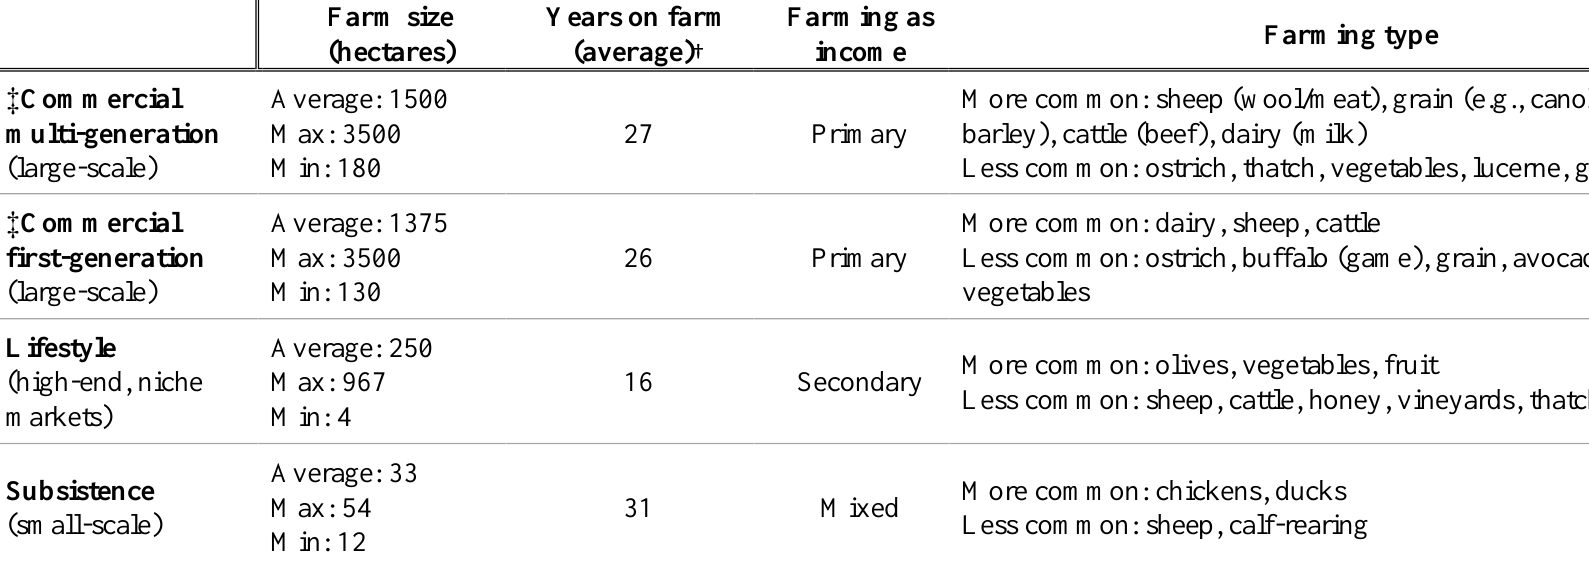
Table A1.1: Typologies of active farmers who participated in semi-structured interviews. Farm